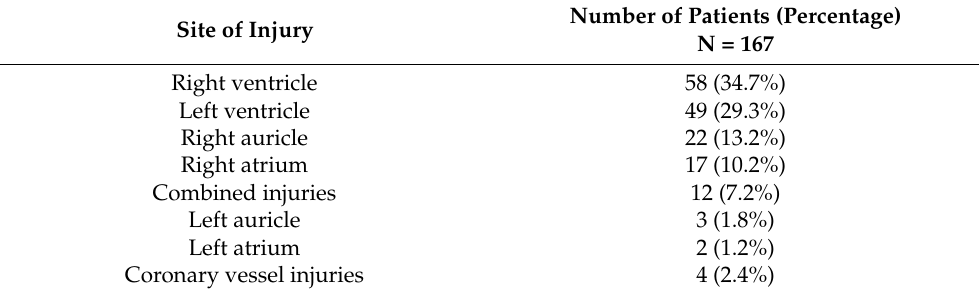
Table 3. Site of cardiac